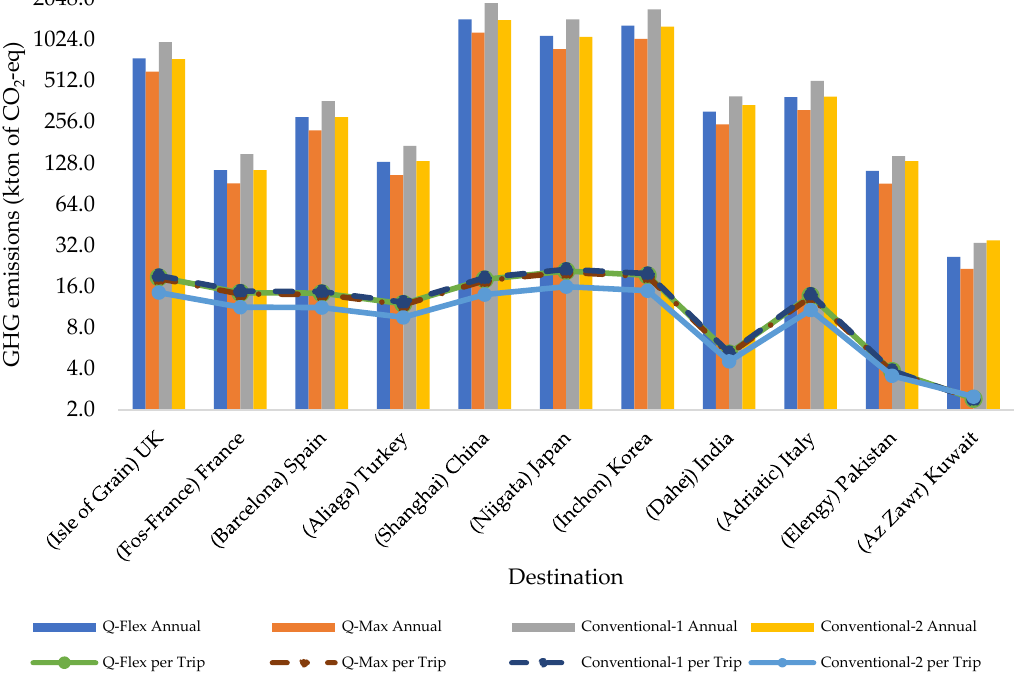
Figure 4. CO 2 -eq emission results for the roundtrip and annual.